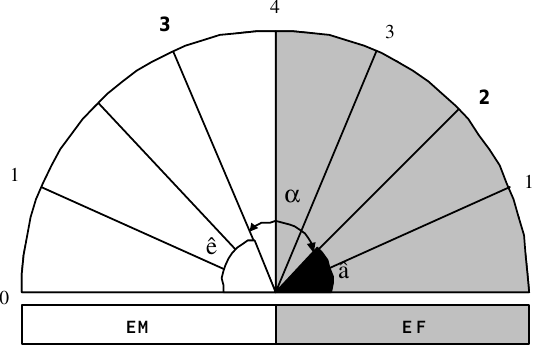
Figure 1 . Graphic representation showing the schemas M and